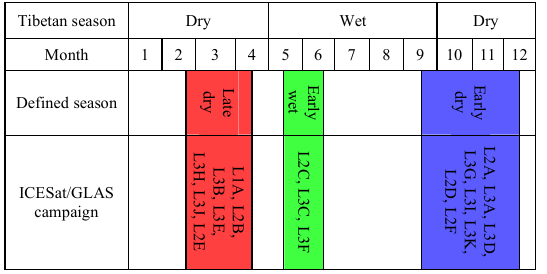
Table 1. Classifying the ICESat/GLAS campaigns based on the Tibetan seasonal characteristics According to the ICESat/GLAS campaign schedule (NSIDC, 2011), for each lake the dataset of mean elevations is divided into 3 different seasonal groups: late dry, early wet and early dry, related to the Tibetan seasons as shown in Table 1. A seasonal lake level trend for a certain season is estimated by linear regression if the lake is sampled by at least three campaigns in that season. The slope of the seasonal trend indicates the rate of the seasonal lake level change per year while the RMSE (Root Mean Square Error), as a standard deviation of residuals, consists of a combination of possible